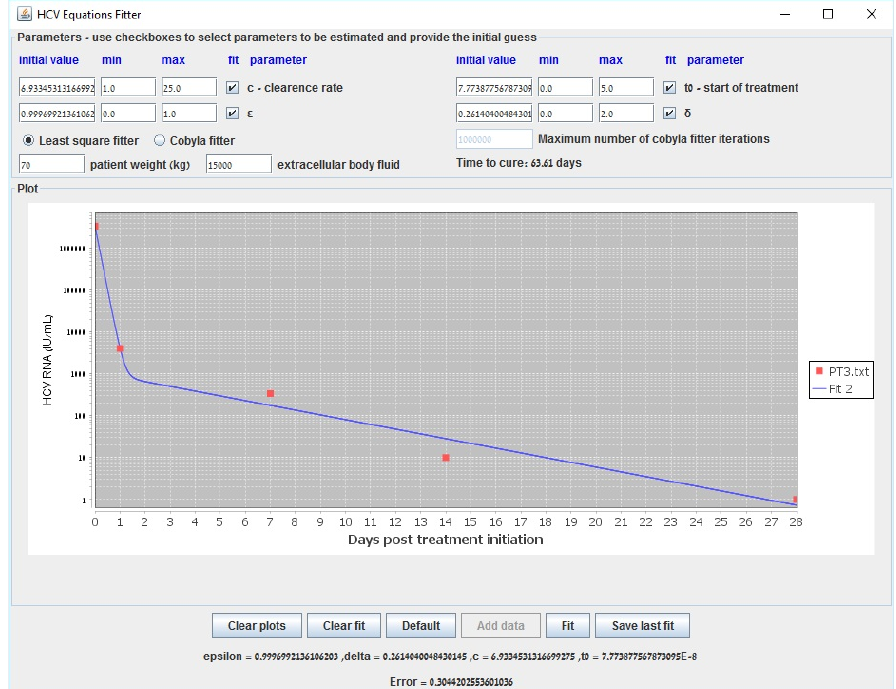
Figure A6. Biphasic model fitting example with data taken from [36] of a patient who was treated with mavyret. The LSF method (default) is recommended for use.